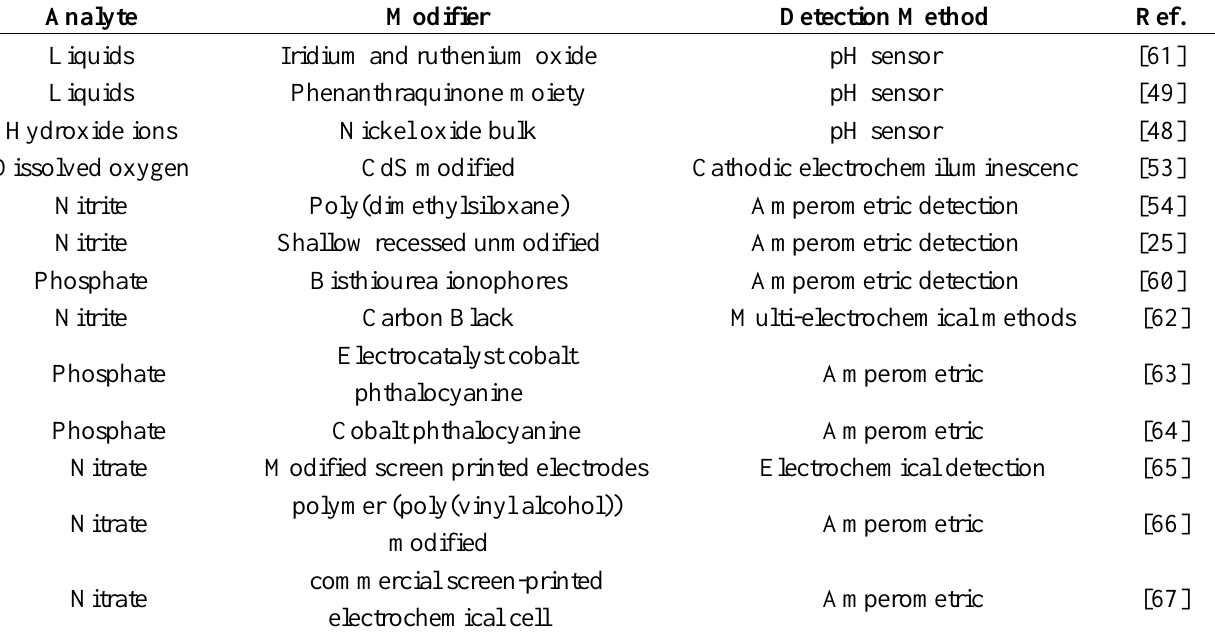
Table 1. Some of the recently developed screen printed sensors for water quality